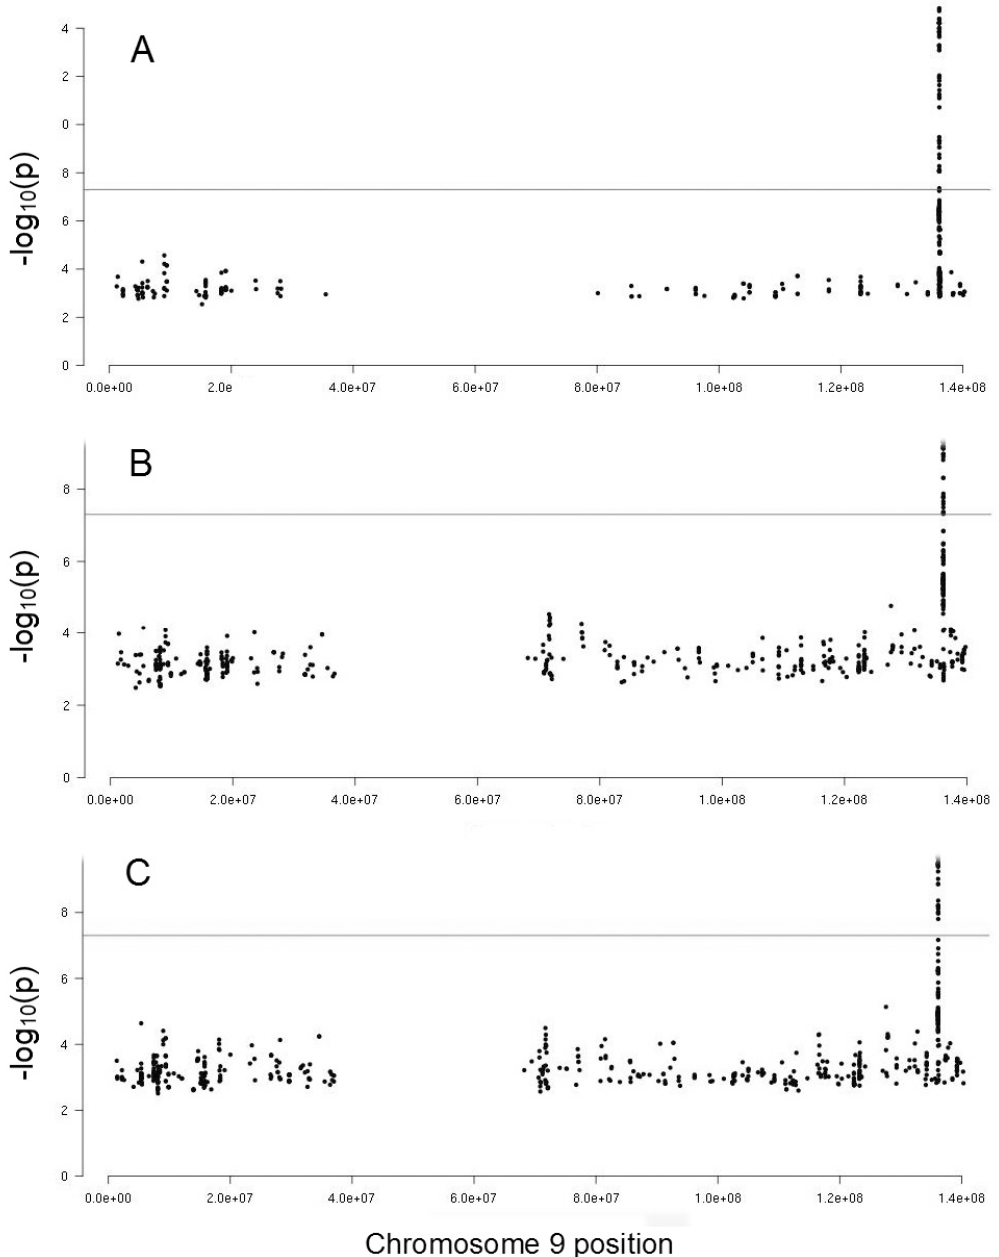
Figure 2. Manhattan plots of the chromosome 9 region of the GWAS on collagen-ADP closure time phenotype: ( A ) without adjustments, ( B ) after adjusting for von Willebrand factor, and ( C ) after adjusting for factor VIII. Dots correspond to SNPs organized by position and the vertical axis shows the statistical significance expressed as -log 10 of the p -values. The horizontal lines mark the 5 × 10 − 8 p -value threshold of genome-wide significance.